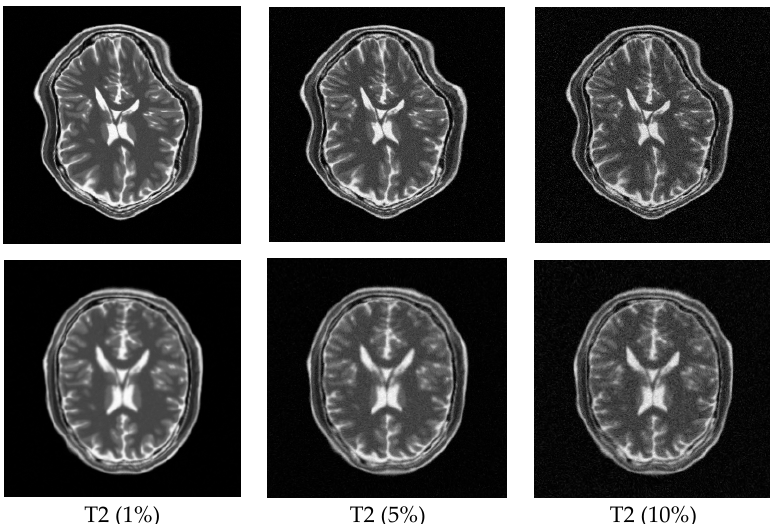
Figure 12. Registration results for T1–T2 images with different levels of Rician noise. The first row shows the T2-weighted floating images with 1%, 5%, and 10% Rician noise, respectively. The second row corresponds to the registered results for the PSR method.